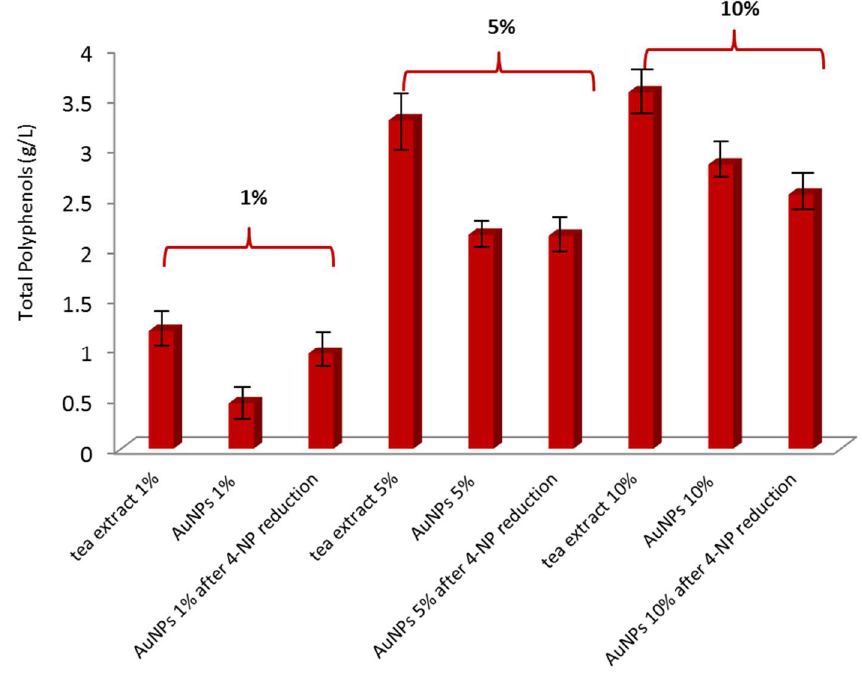
Figure 5. Concentration of total polyphenols in solution (g/L) (4-NP = 4-Nitrophenol).